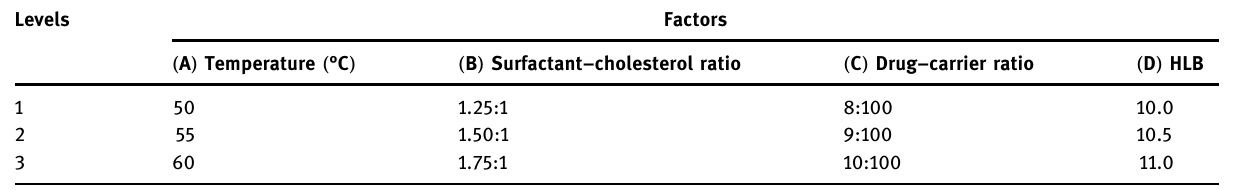
Table 1: Factors and levels of orthogonal experimental design